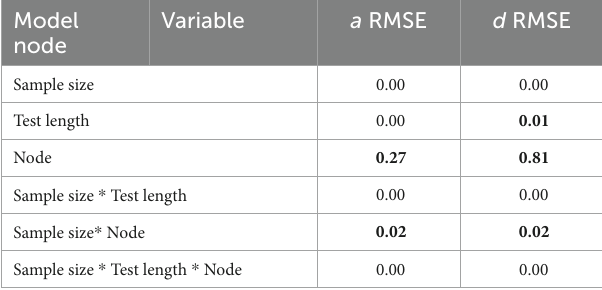
TABLE 5 Accounted variance for parameter recovery metrics for the IRTree MPP model fitted to IRTree MPP model data. Model